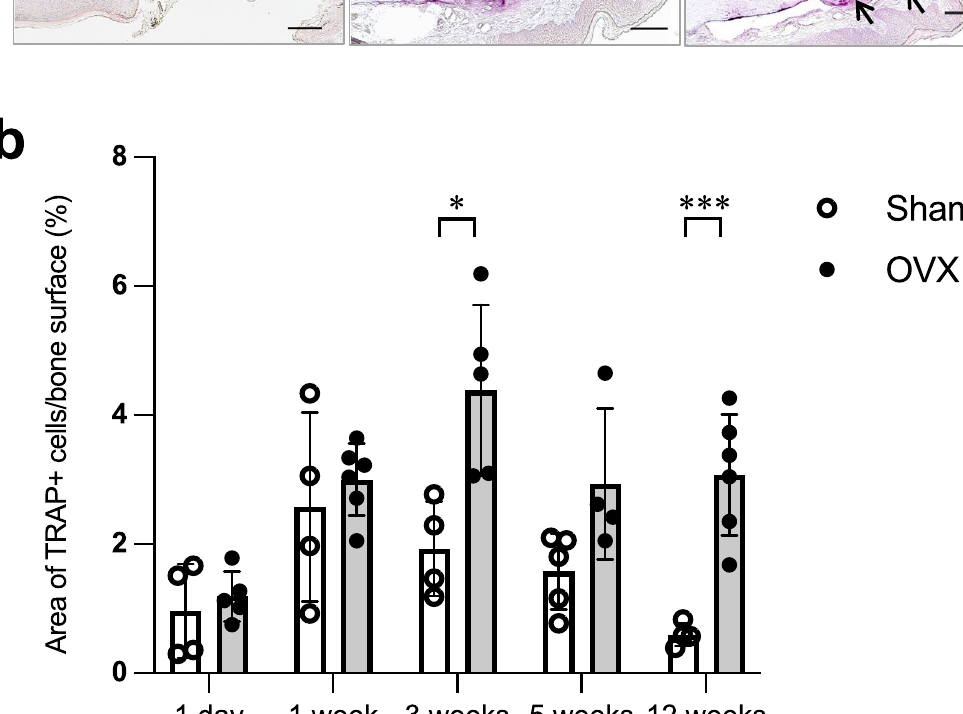
Figure 3. Prolonged increase of osteoclasts in the maxillary bone of OVX mice. ( a ) Enzymatic histochemistry staining for TRAP (red) on the decalcified maxillary alveolar bone at day 1, 3 weeks, and 12 weeks of sham or OVX mice following teeth extractions. The arrows indicate TRAP-positive signals inside and around the extraction socket. The arrowheads indicate TRAP-positive signals on the buccal side of the maxillary alveolar bone. Bars: 100 μm. ( b ) The graph shows the time-dependent changes in the ratio of the total area of TRAP- positive cells to the surface area of the maxilla alveolar bone of the extracted side in sham or OVX mice. The bone of the extracted side was around M2. Data are expressed as mean ± S.D. (sham mice: n = 4–5. OVX mice: n = 4–6), * P < 0.05, *** P < 0.005; calculated using calculated using Student’s t